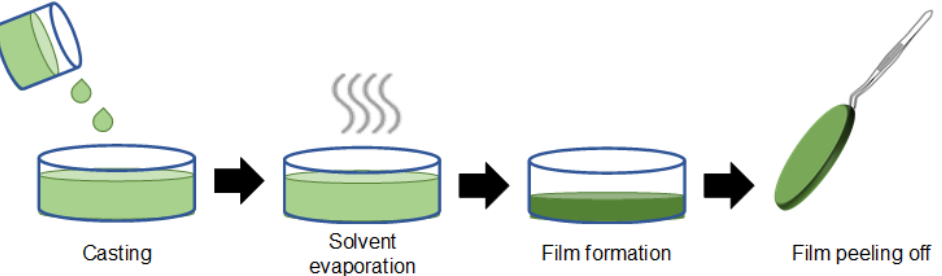
Figure 9. Illustration of film formation by conventional solvent